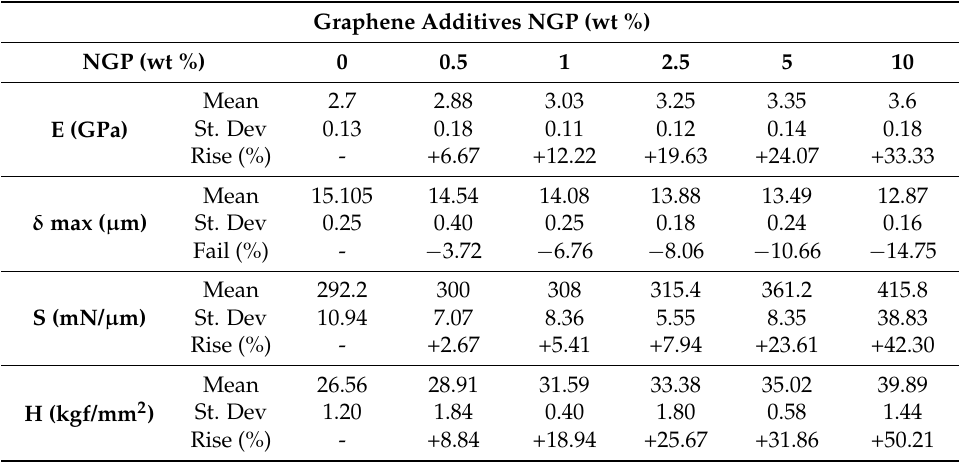
Table 3 . Mechanical properties versus graphene weight fractions. Table 3. Mechanical properties versus graphene weight